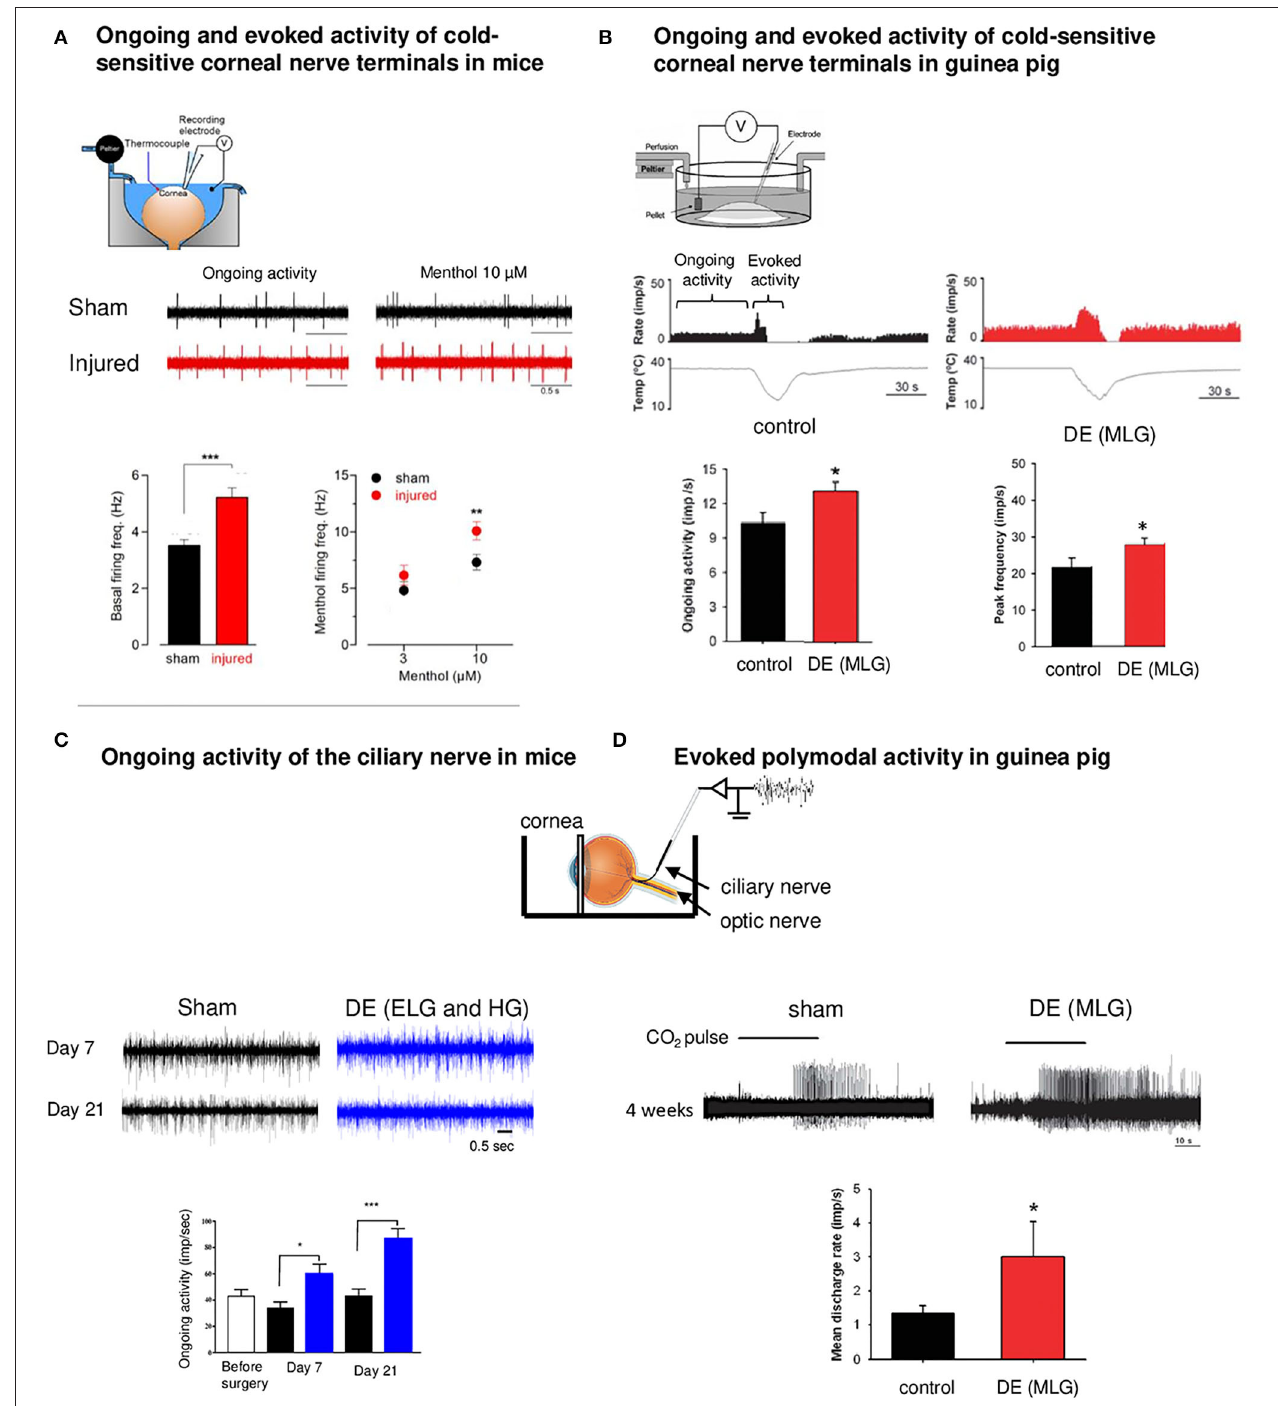
FIGURE 2 | Functional abnormalities of corneal nerves following corneal damage and DE condition. Ex vivo electrophysiological recordings of corneal nerves in models of corneal nerve damage and DE conditions. (A) Electrophysiological set-up. Spontaneous (ongoing) and evoked (menthol 10 µ M) activity of cold sensitive corneal nerve terminals in a mouse model of corneal nerve injury (red traces) relative to control (sham animals, black traces). Note the increase in corneal nerve activity for both conditions in the injured cornea. Data plotted as mean ± SEM. * P < 0.05, ** P < 0.01, *** P < 0.001. (B) Electrophysiological set-up of ongoing and evoked activity of cold nerve terminals in a guinea pig model of DE obtained after the main lachrymal gland (MLG) excision. Ongoing activity and peak frequency evoked by cooling-ramp were increased 4 weeks after MLG excision. (C) Electrophysiological set-up for extracellular recording of the ciliary nerve. Ongoing ciliary nerve activity 7 days and 21 days after the excision of extraorbital (ELG) and Harderian gland (HG) in mice (blue traces) relative to sham animals (black traces). In both conditions, we noted higher ongoing (spontaneous) firing frequency in DE animals. (D) Activity of polymodal nerve fibers activated by 30s CO 2 pulse in control (sham) and